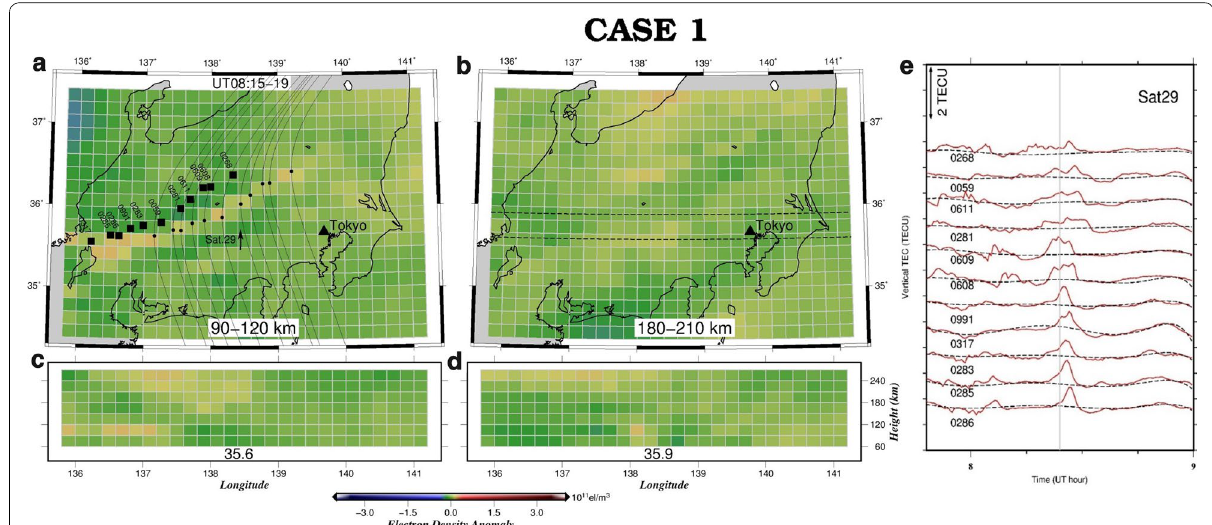
Fig. 6 Results of 3D tomography (average of the results at 8:15, 8:17, 8:19 UT) of Case 1 Es patch that occurred on May 14, 2010, above the Kanto District (Maeda and Heki 2014, 2015). Black curves in a describe the tracks (moving northward) of the intersection of LoS with a thin layer at 100-km altitude (black dots show the positions at 8:23 UT, and black squares indicate the GNSS stations) for the station–satellite pairs shown in e . We show the map views at altitudes 90–120 km ( a ) and 180–210 km ( b ), and latitude–height profiles at 35.6° N ( c ) and 35.9° N ( d ). Time series (red curves) showing VTEC residuals 7:50–09:00 UT from reference curves, observed at eleven GNSS stations (black rectangle in a ) with GPS satellite 29, show typical Es signatures as short-period positive pulse around 8.5 UT ( e )